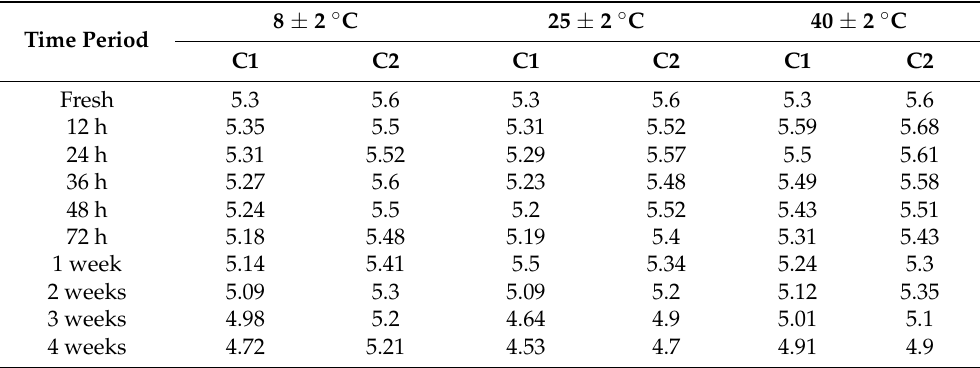
Table 2. pH value of formulations at 8 ± 2 ◦ C, 25 ± 2 ◦ C, 40 ± 2 ◦ C.